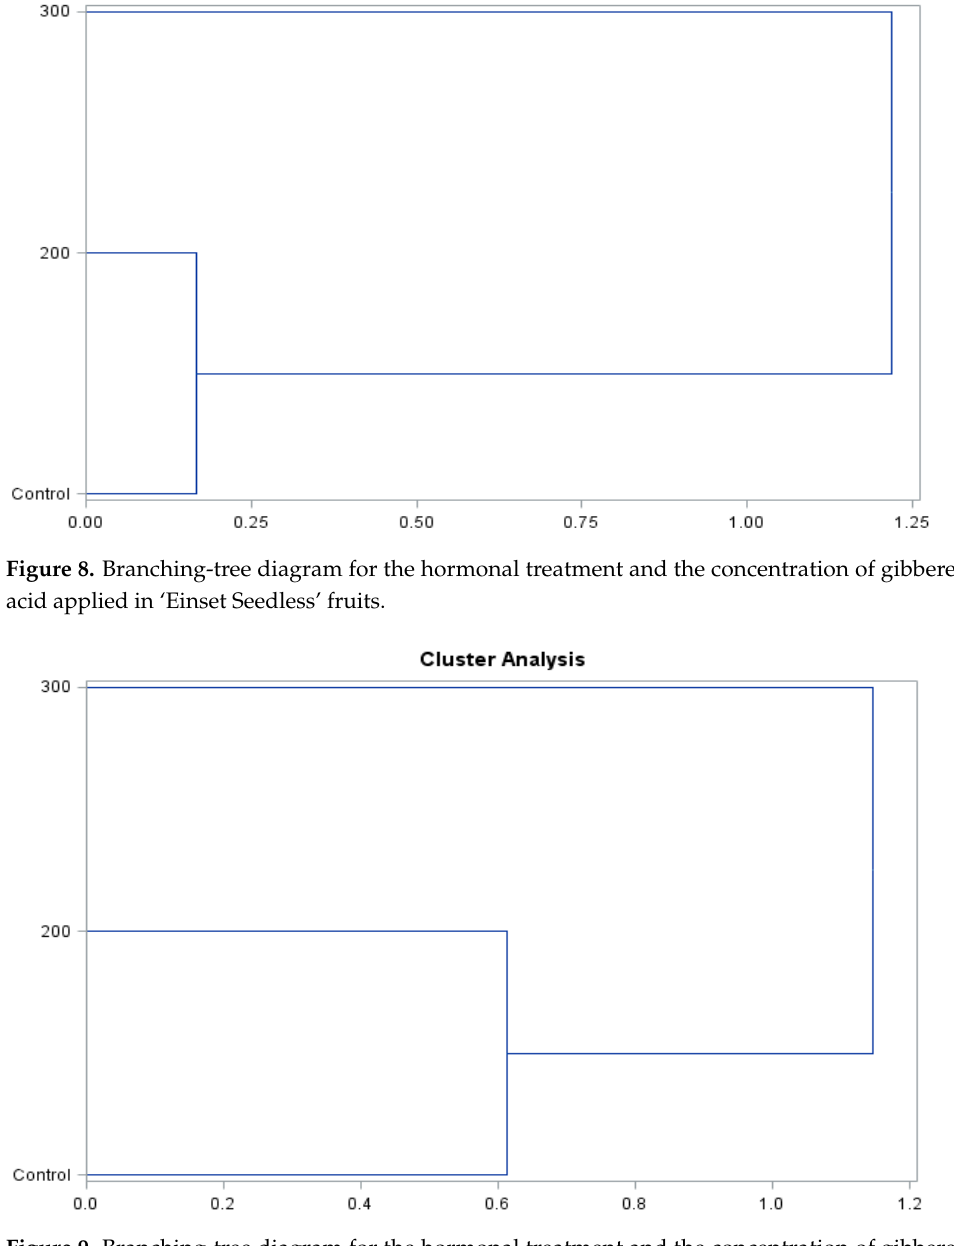
Figure 9. Branching-tree diagram for the hormonal treatment and the concentration of gibberellic acid applied in ‘Einset Seedless’